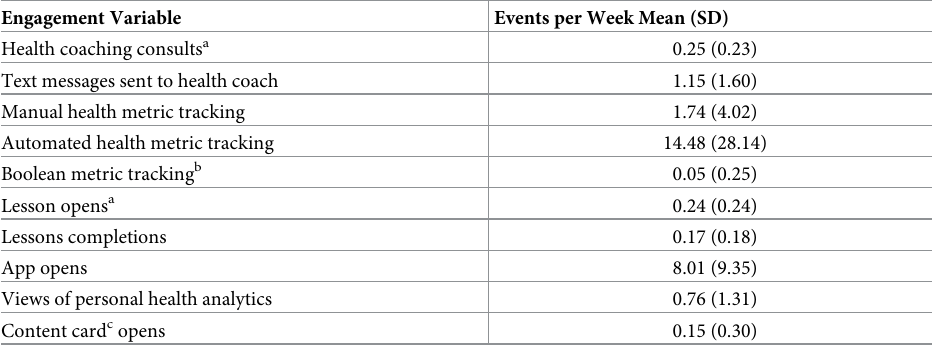
Table 4. Means (SDs) of engagement